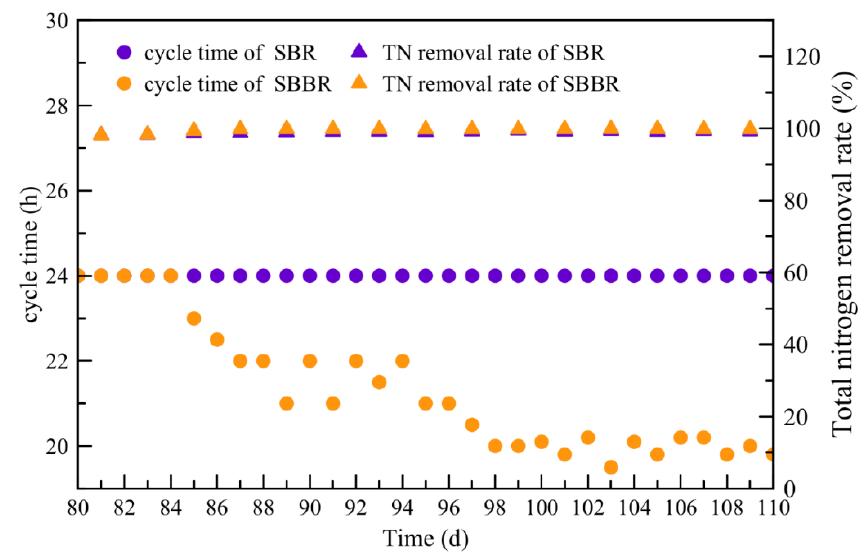
Figure 5. Comparison of reaction cycles between SBR and SBBR.